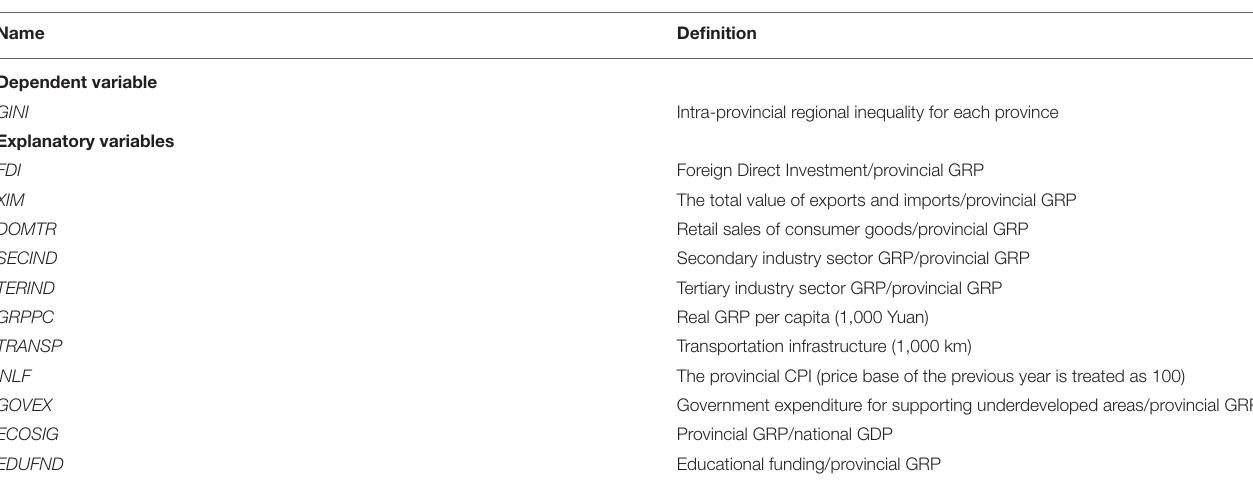
TABLE A1 | Variables used in the baseline model (presented in Table 2